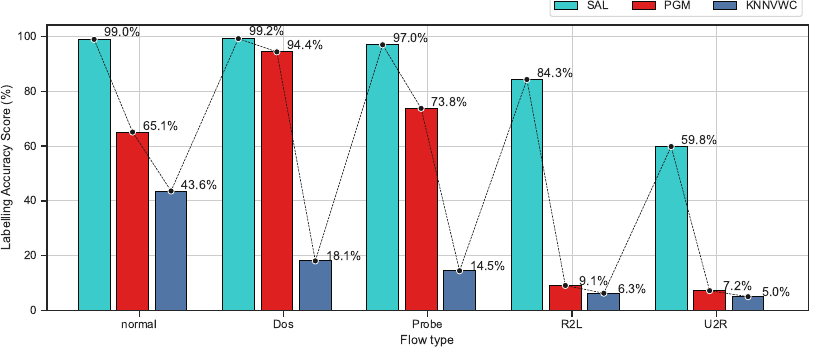
Figure 9. Comparison of labeling processes based on F-measure metrics on the NSL-KDD dataset.